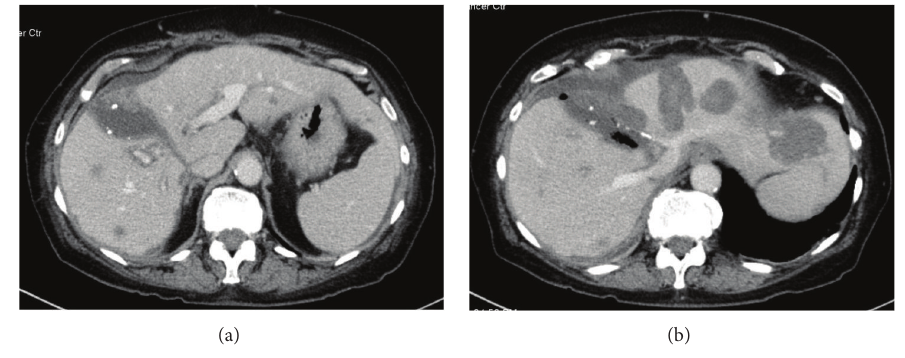
Figure 3: Post-FLR hypertrophy.